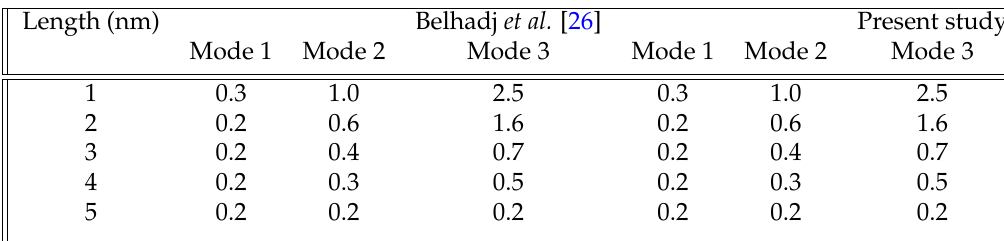
Table 3. Comparison of the present study with exact solution of Belhadj et al. [26] for pinned - pinned condition for the frequency of the SWCNT (THz)